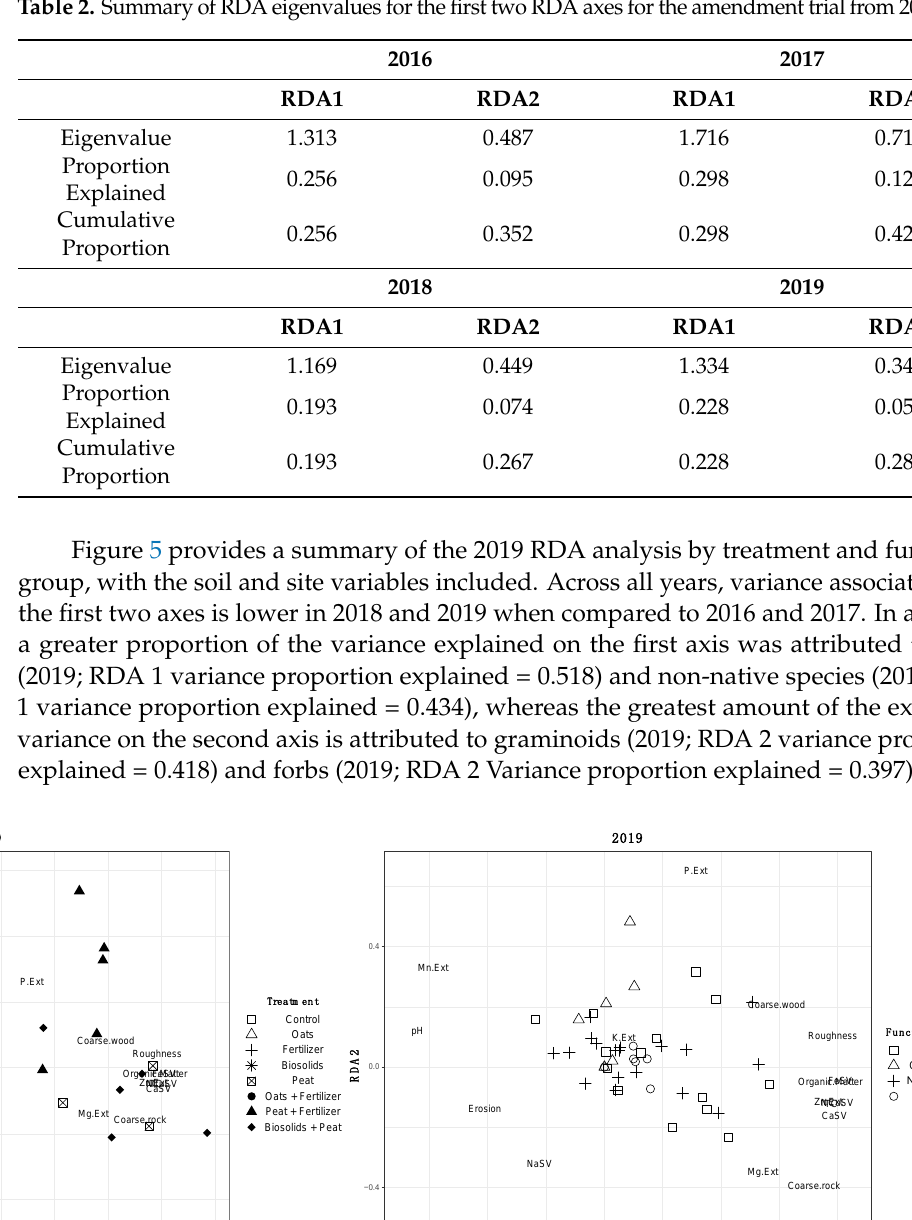
Figure 5. Vascular plant functional groups and amendment treatment ordination using RDA models for 2019 data with soil and site variables.